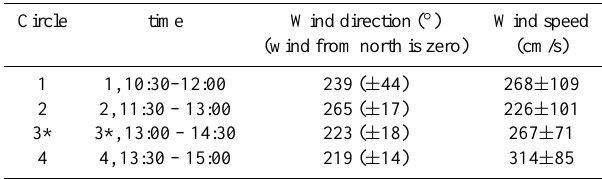
Table 1. Wind data calculated from three stations (Mannheim cen- ter, south, north, see Fig. 5). For each cycle, the average and stan- dard deviation of wind speed and direction are calculated.